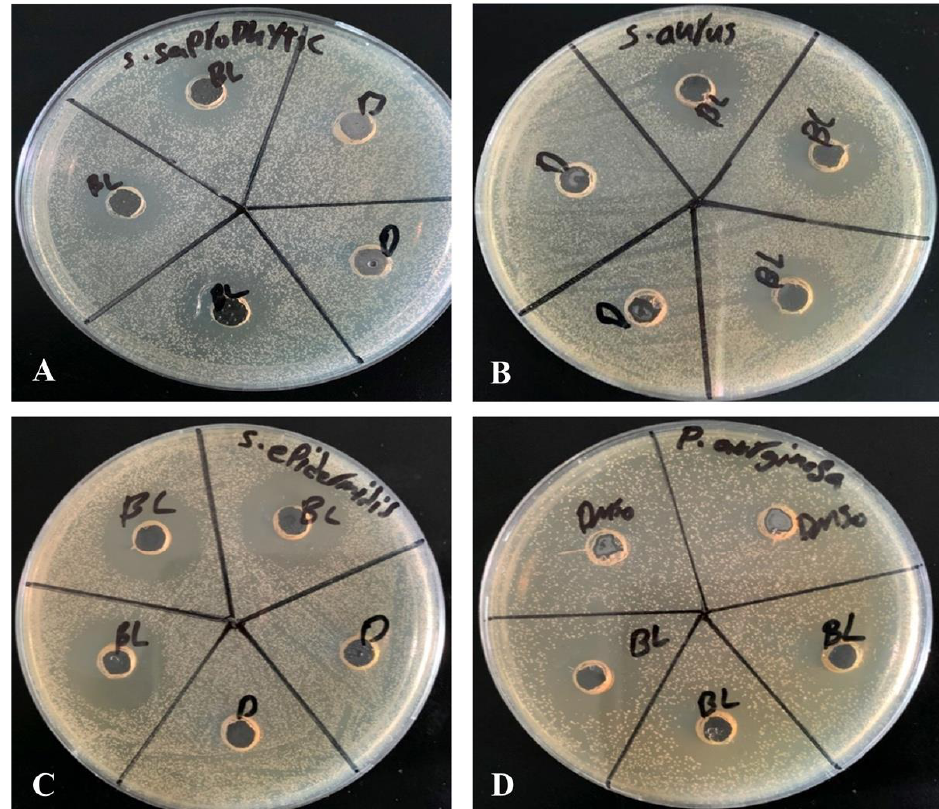
Figure 1. Zone of inhibition of susceptible strains: 20 µL each of β-Lap (2.5 mM) and DMSO were dispensed in triplicate and duplicate wells, respectively, of the plates uniformly streaked with bacterial suspension of ( A ) S. saprophyticus , ( B ) S. aureus , ( C ) S. epidermidis , and ( D ) P. aeruginosa (ATCC 27853) .